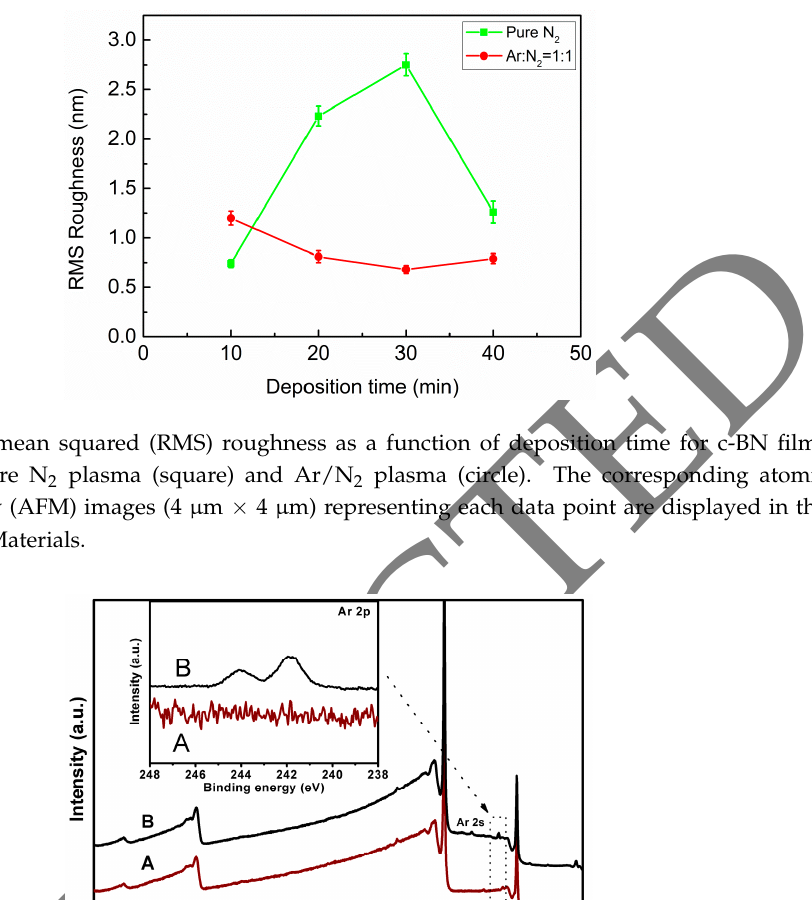
Figure 4. X-ray photoelectron spectrometry (XPS) survey spectra for c-BN films with (A) pure plasma and (B) mixed Ar/N 2 plasma after 10 min deposition. The inset shows Ar 2 p core level spectra for the c-BN films.